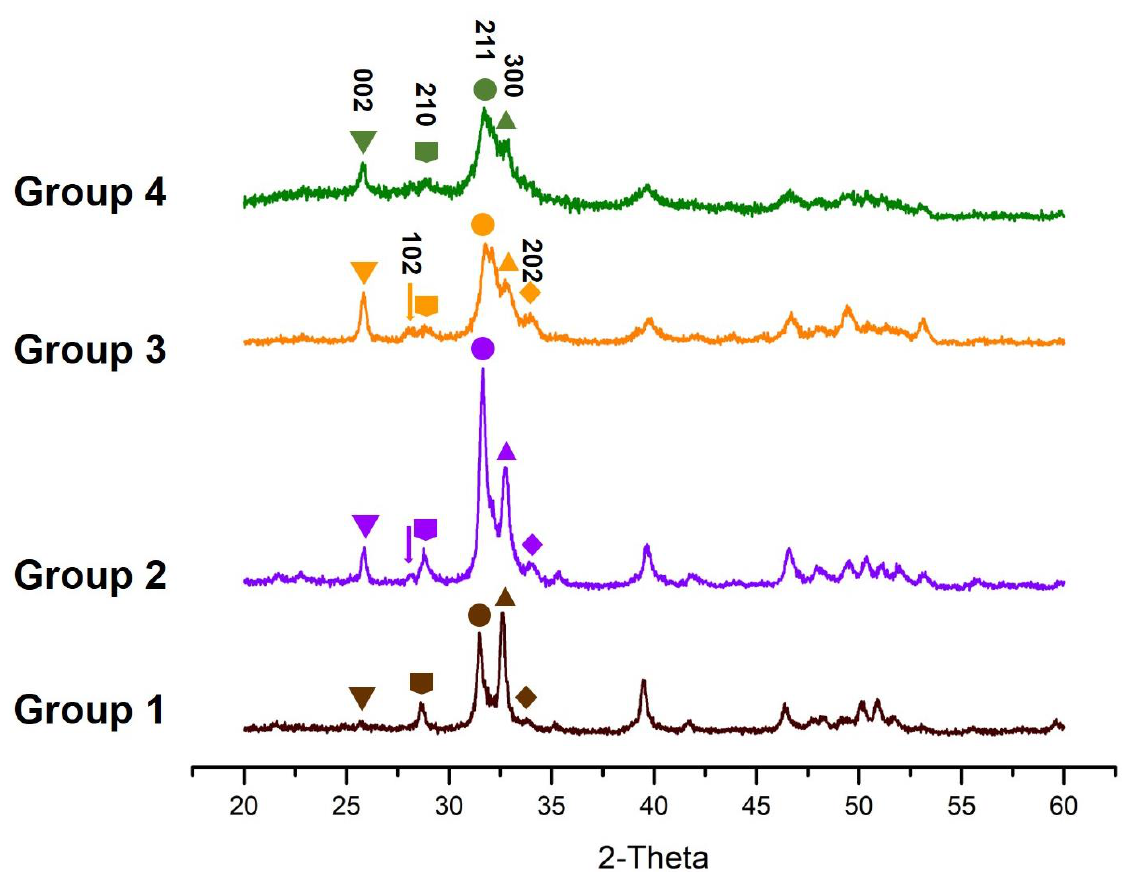
Figure 6. XRD patterns of the four groups: Group 1 (SBAG), Group 2 (SBAG+F), Group 3 (F) and Group 4 (Control).